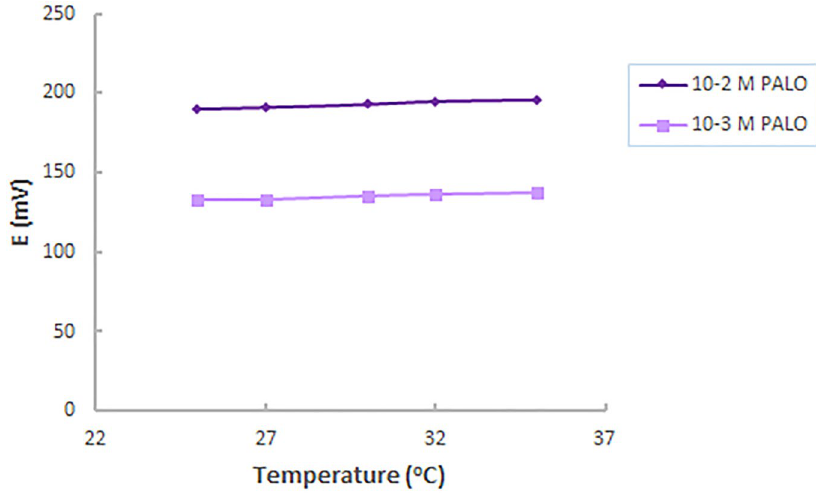
Figure 3. Effect of temperature on the performance of ionophore-free sensor.